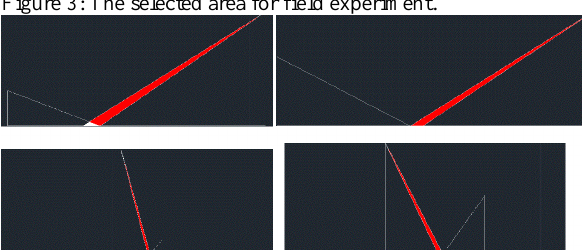
Figure 3: The selected area for field experiment.